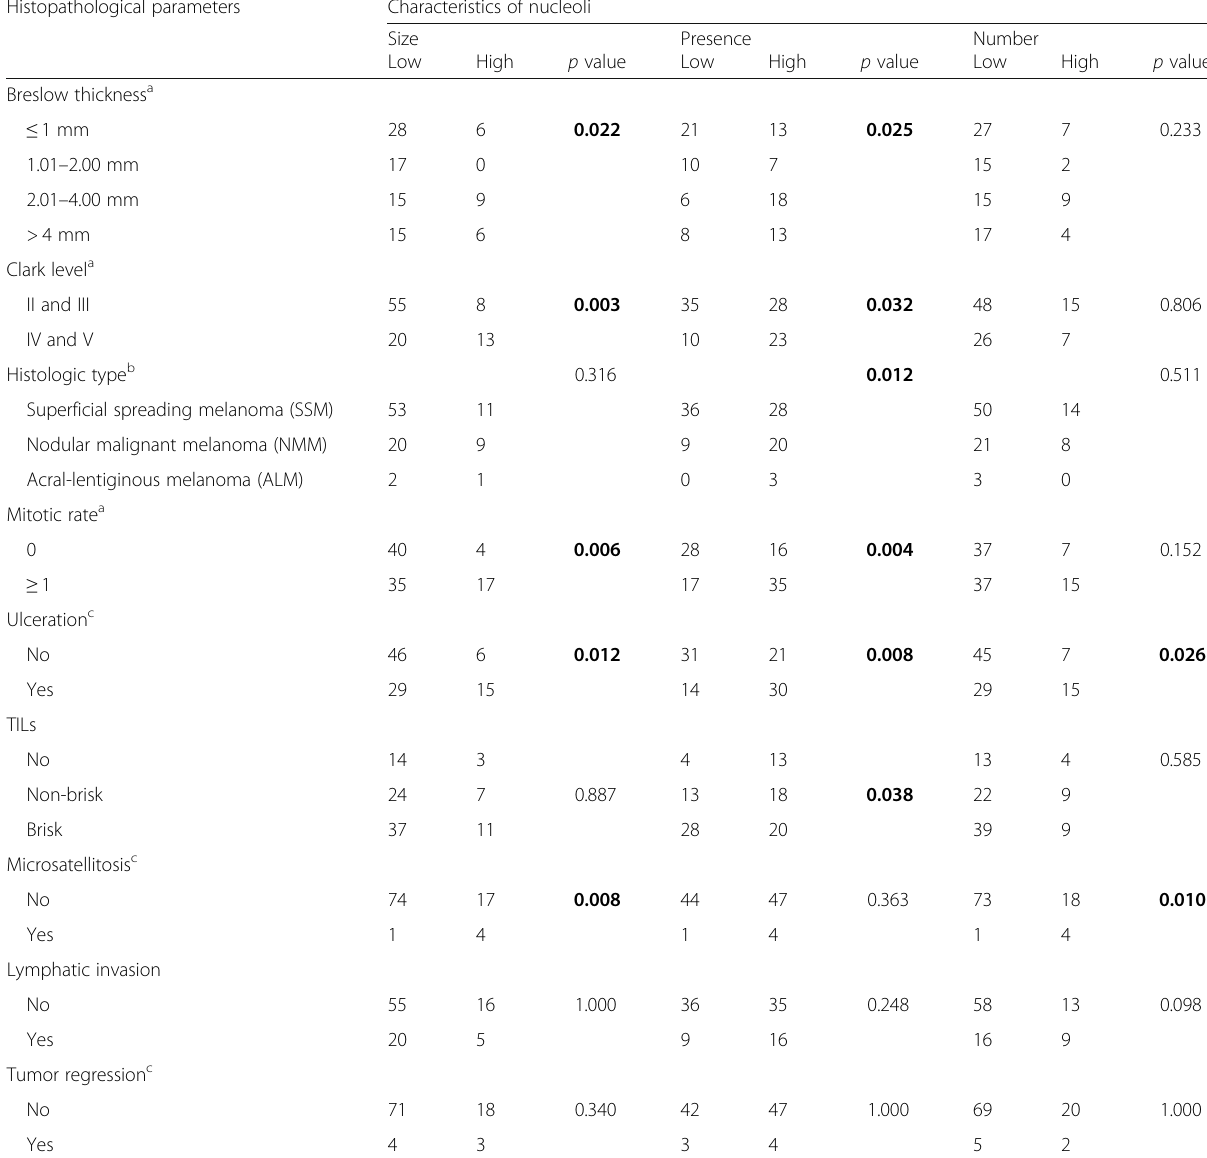
Table 2 Correlations between characteristics of nucleoli and presence of intranuclear vacuoles in malignant melanocytes and histopathological